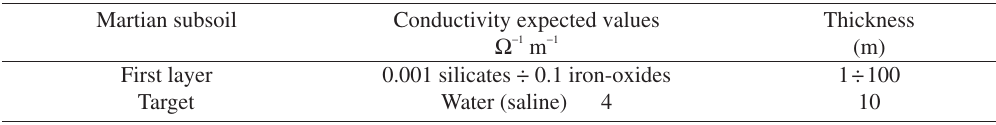
Table III . Conductivity profile range of